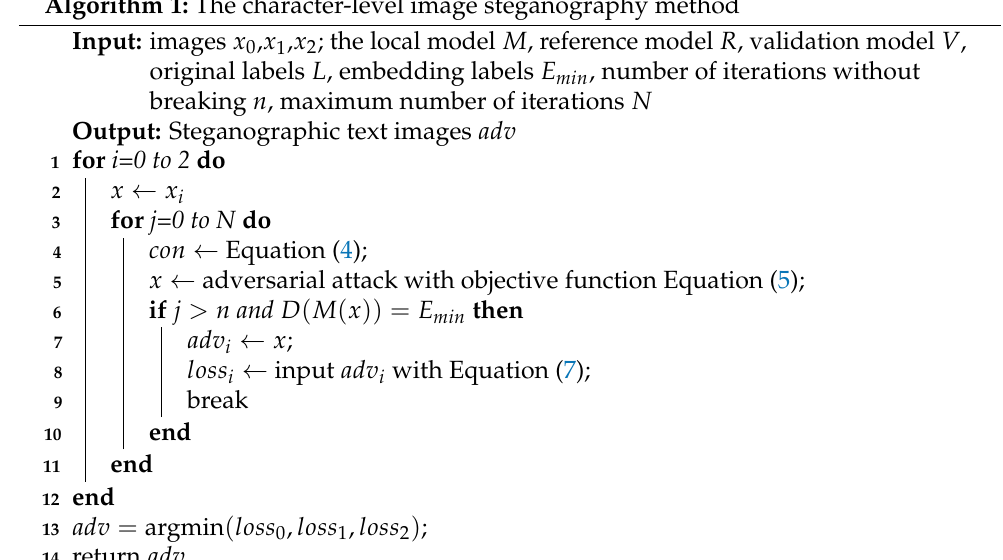
Algorithm 1: The character-level image steganography